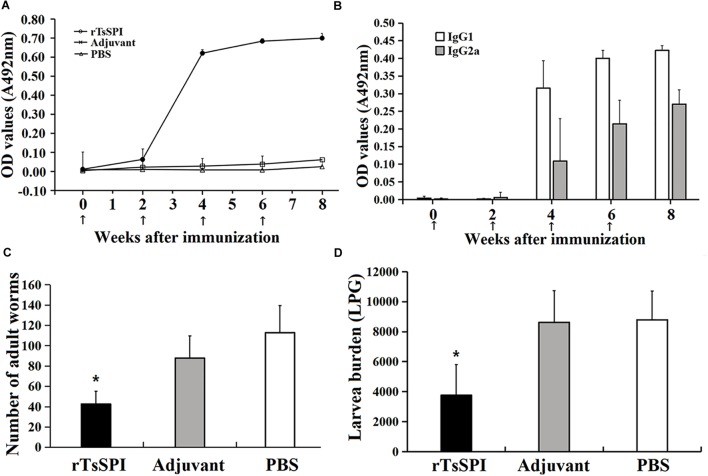
Protective immunity in mice immunized with rTsSPI. Serum IgG (A) and IgG subtype (B) responses to the rTsSPI at different times post immunization were measured by ELISA. The data are presented as the mean OD values ± SD of specific anti-rTsSPI antibodies from ten mice. The arrow (↑) represents immunization times. The number of adults recovered from intestines (C) and larvae per gram (LPG) of muscles (D) in immunized mice after challenge with 300 T. spiralis muscle larvae. Results are expressed as the mean ± SD of 10 mice per group. An obvious reduction was observed in the worm burdens of intestinal adults at 6 dpi and muscle larvae at 35 dpi (∗P < 0.01).